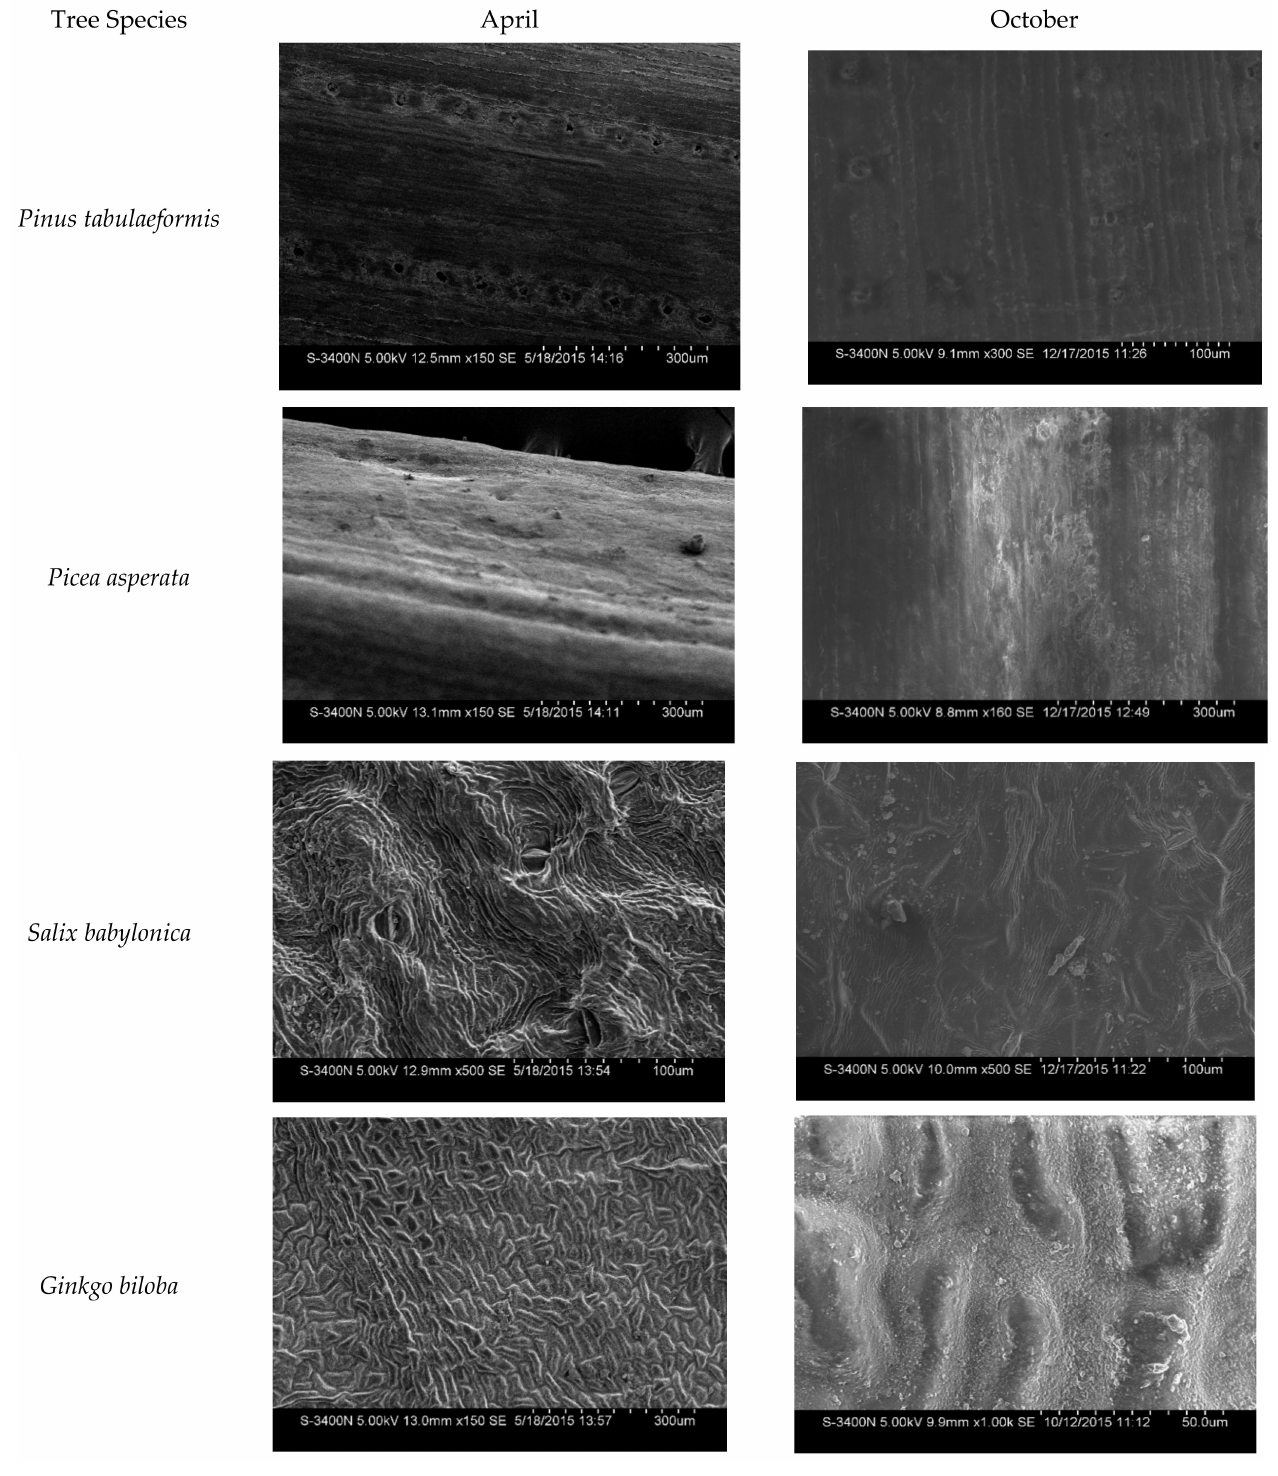
Figure 3. Leaf morphological characteristics of typical tree species in April and